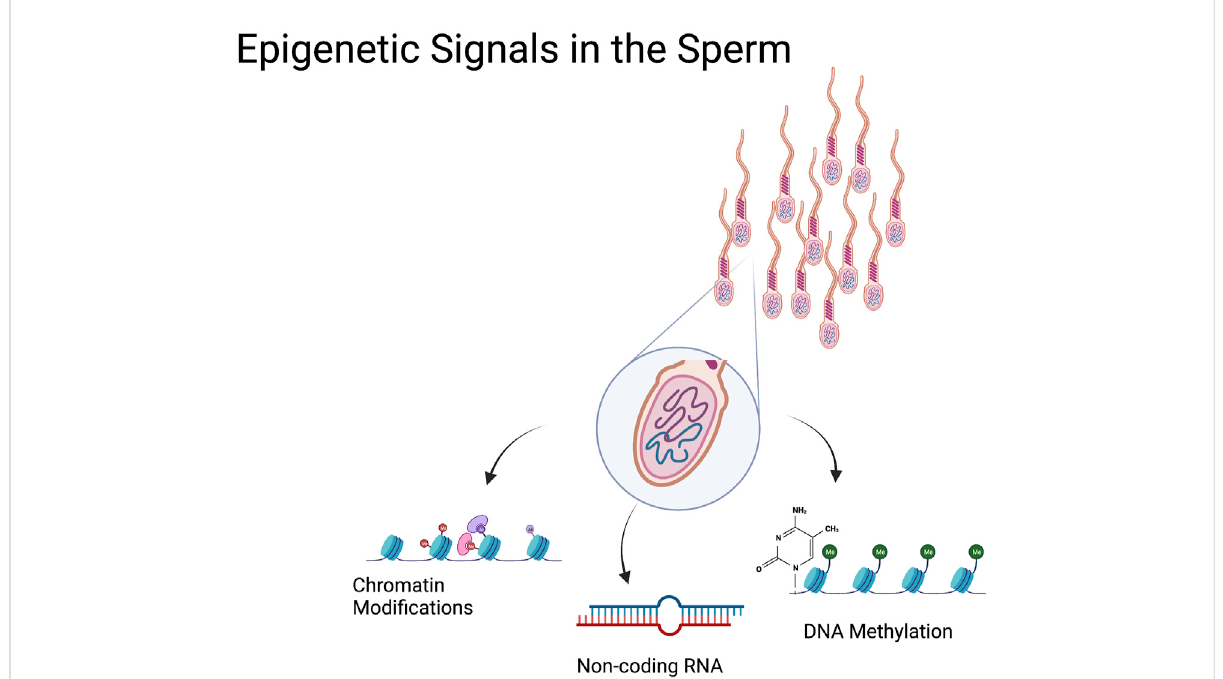
FIGURE 1 Epigenetic Signals in the Sperm. In addition to the paternal genome, sperm cells transmit epigenetic information from the sire to the offspring. These ‘ epigenetic signals ’ include a variety of sperm histone posttranslational modi fi cations that are retained during spermatogenesis and may transmit to the developing embryo. Sperm DNA methylation is another epigenetic modi fi cation carried by the sperm that has the potential to in fl uence embryonic transcription.Sperm also carryawide range ofnoncoding RNAs (miRNA, tRFs, piRNA) that in fl uencezygotictranscription. These epigenetic signals enable the transmission of nongenomic information to the